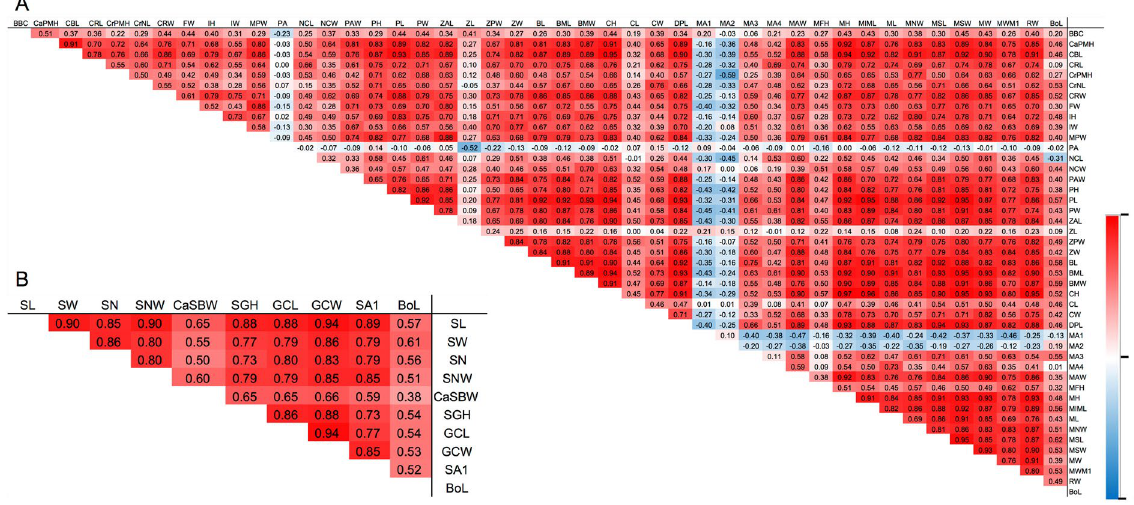
Figure 7. Pearson’s correlation coefficients between each parameter of dugong skulls ( A ) and scapulas ( B ). BoL represents body